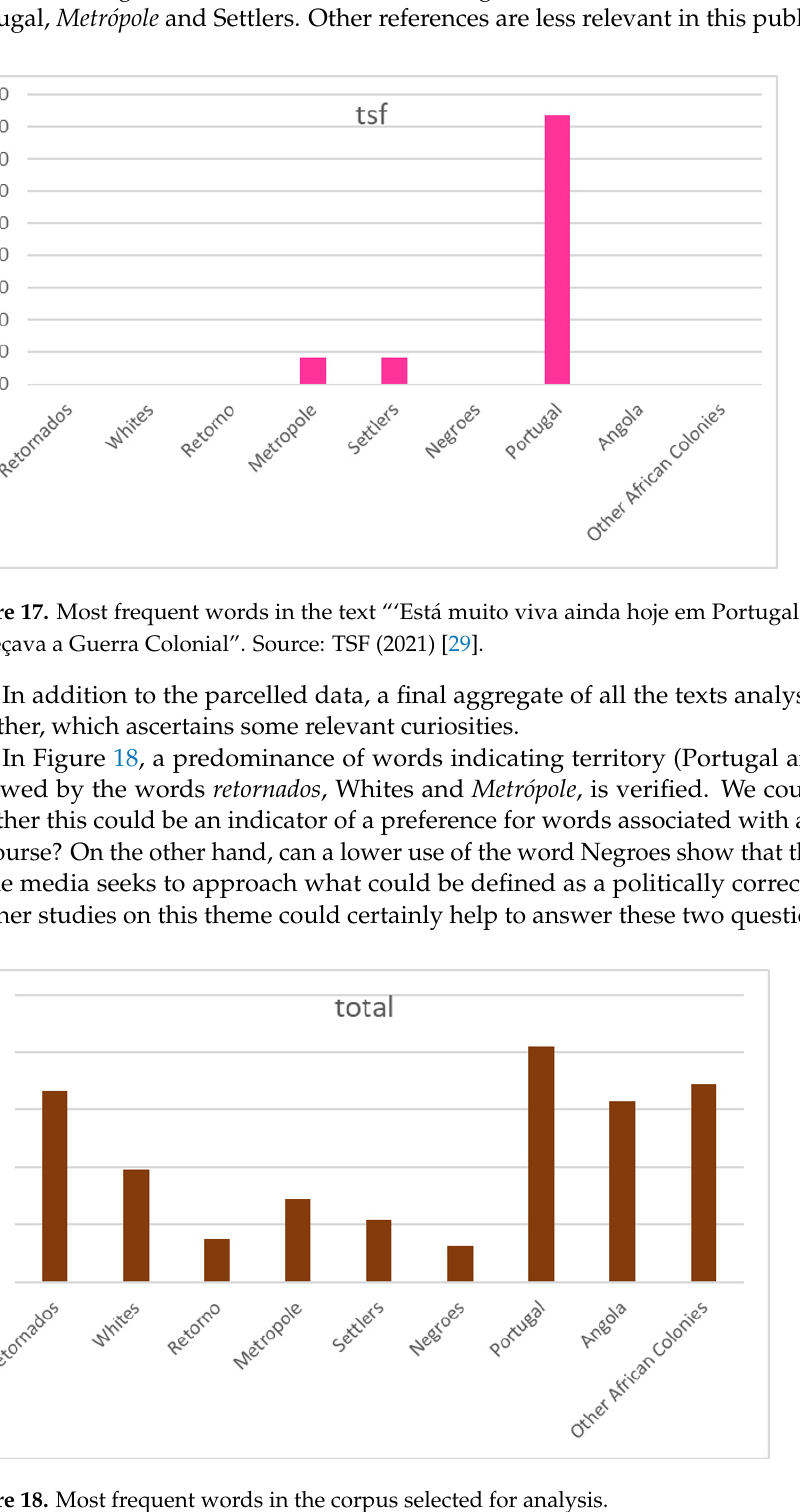
Figure 16. Most frequent words in the text “60 anos depois, ‘continua a ser um desconforto falar sobre a Guerra do Ultramar’”. Source: Rádio Renascença (2021) [14]. Contrasting these data with those of TSF, Figure 17 shows a curious triad in this case: Portugal, Metrópole and Settlers. Other references are less relevant in this publication.